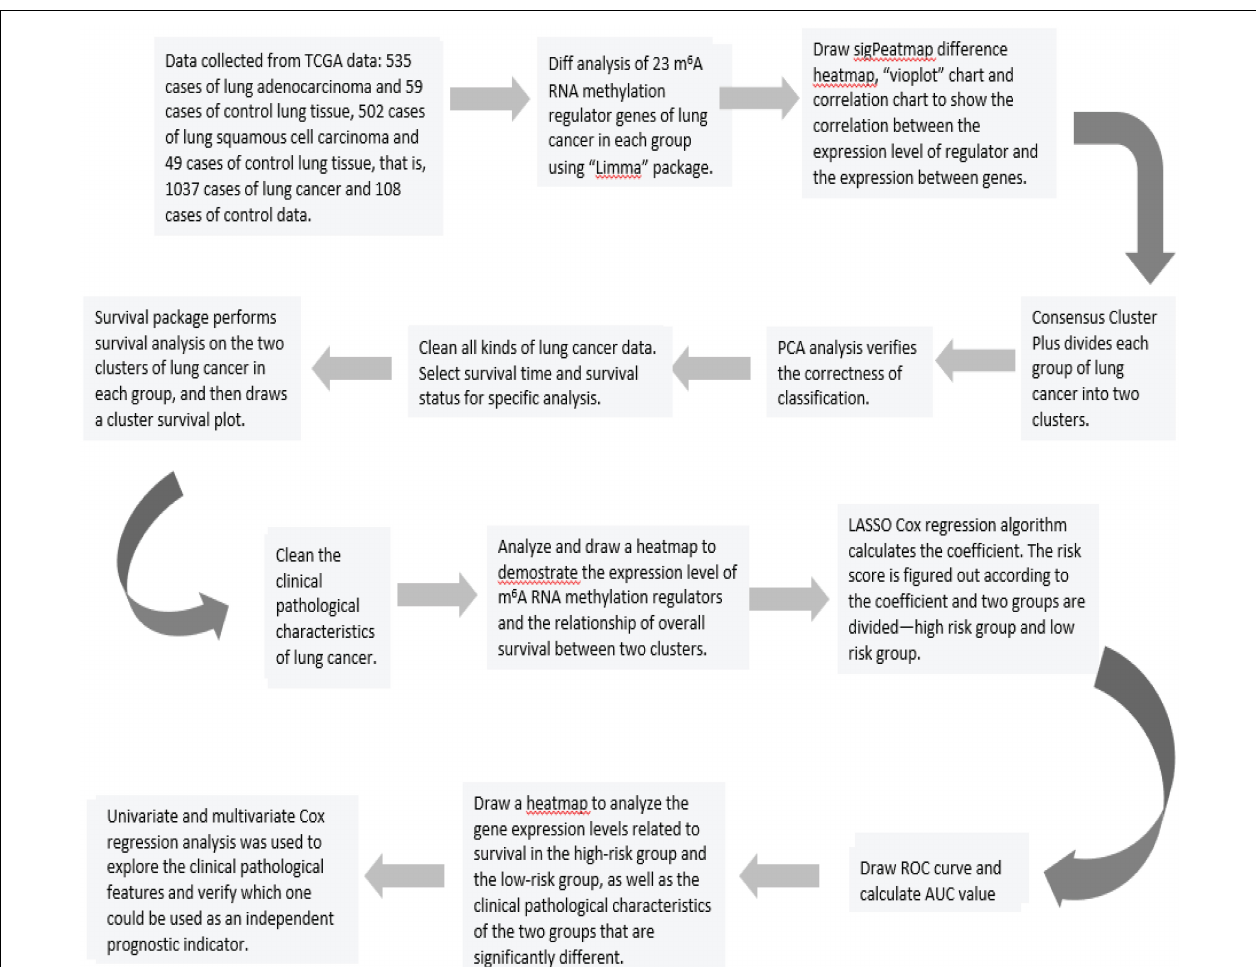
FIGURE 7 | Flow chart for analyzing and processing lung cancer data in the TCGA data set.